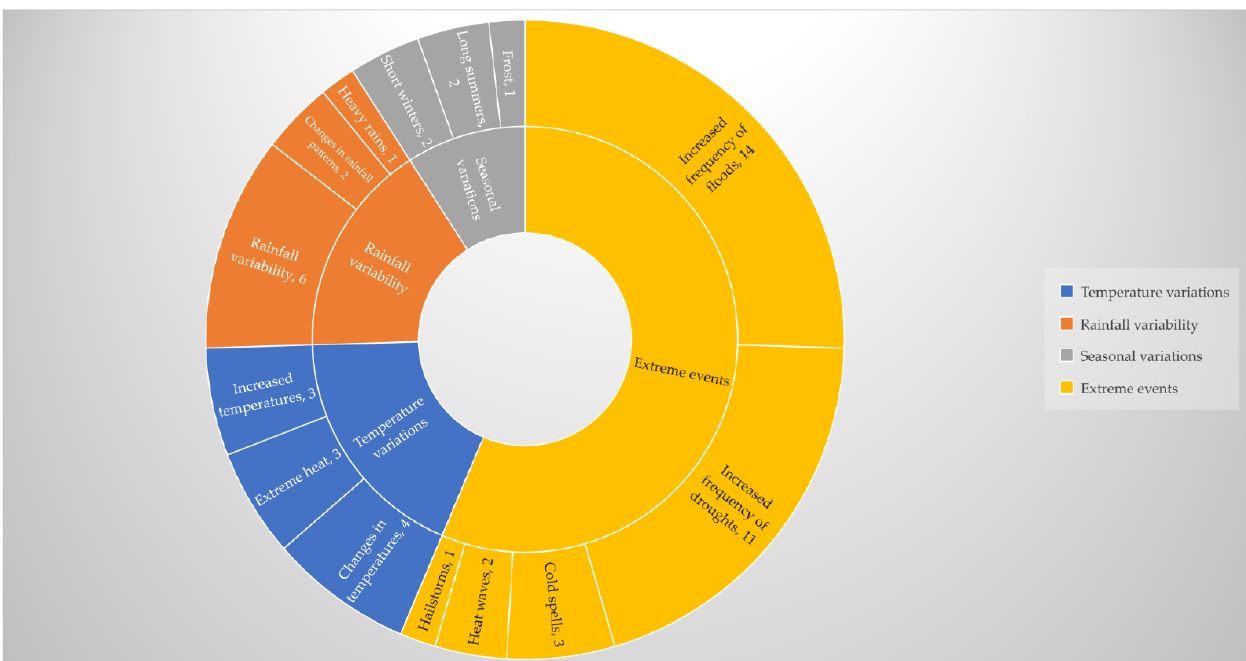
Figure 4. Climate change stressors exacerbating exposure of urban and rural communities in South Africa. Source: Literature review analysis for the period between 2010 and 2021 (South Africa).